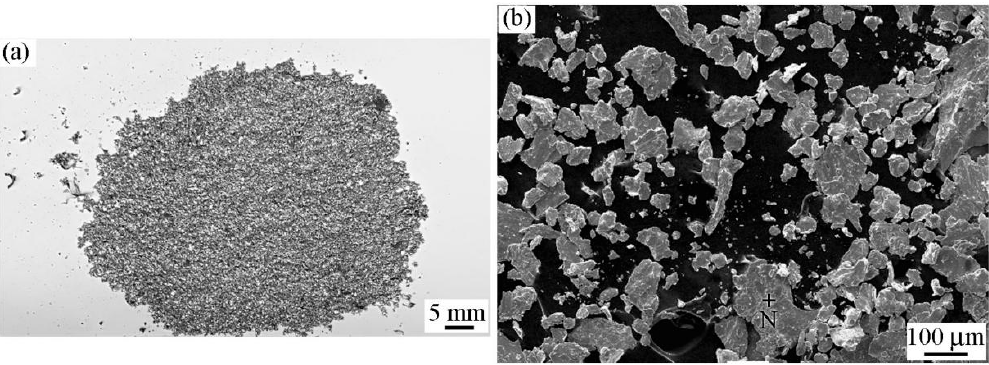
Figure 7. Morphology of the wear debris when the RD was used; H = 26.1 × 10 3 A/m. ( a ) Macro-photograph and ( b ) SEM image.